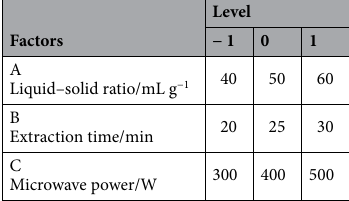
Table 3. Factors and levels in the response surface